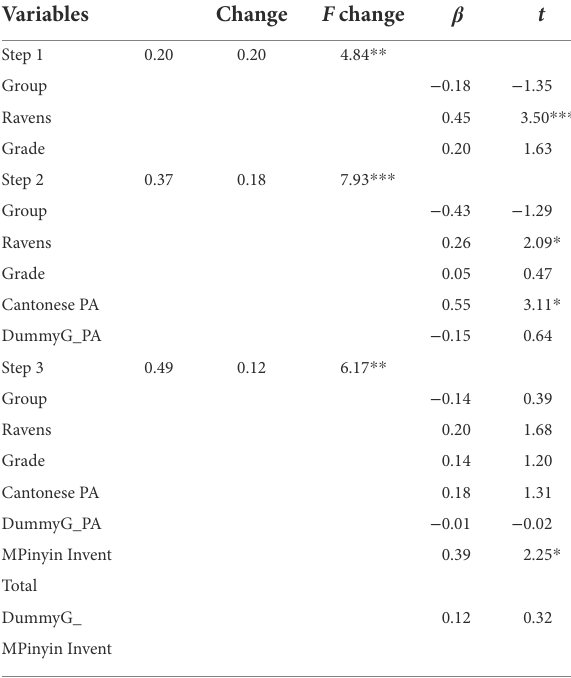
TABLE 3 Summary of Hierarchical regression predicting English Invented Spelling of L1 and L2 Chinese speaking children. Variables